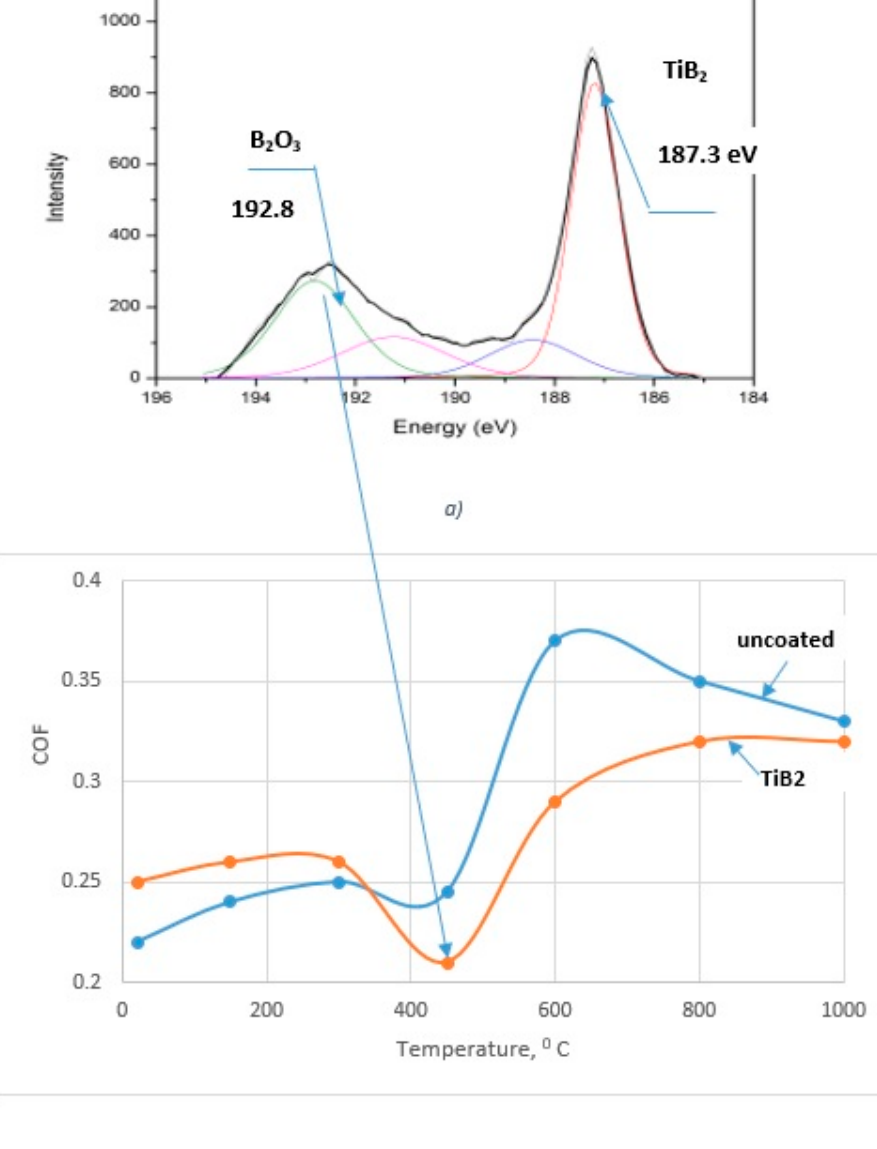
Figure 4. Worn surface of TiB2 coated inserts: ( a ) high resolution B1s X-ray Photoelectron spectrum related to ( b ) COF data vs. temperature. Reproduced from [28,36], with permission from Elsevier,